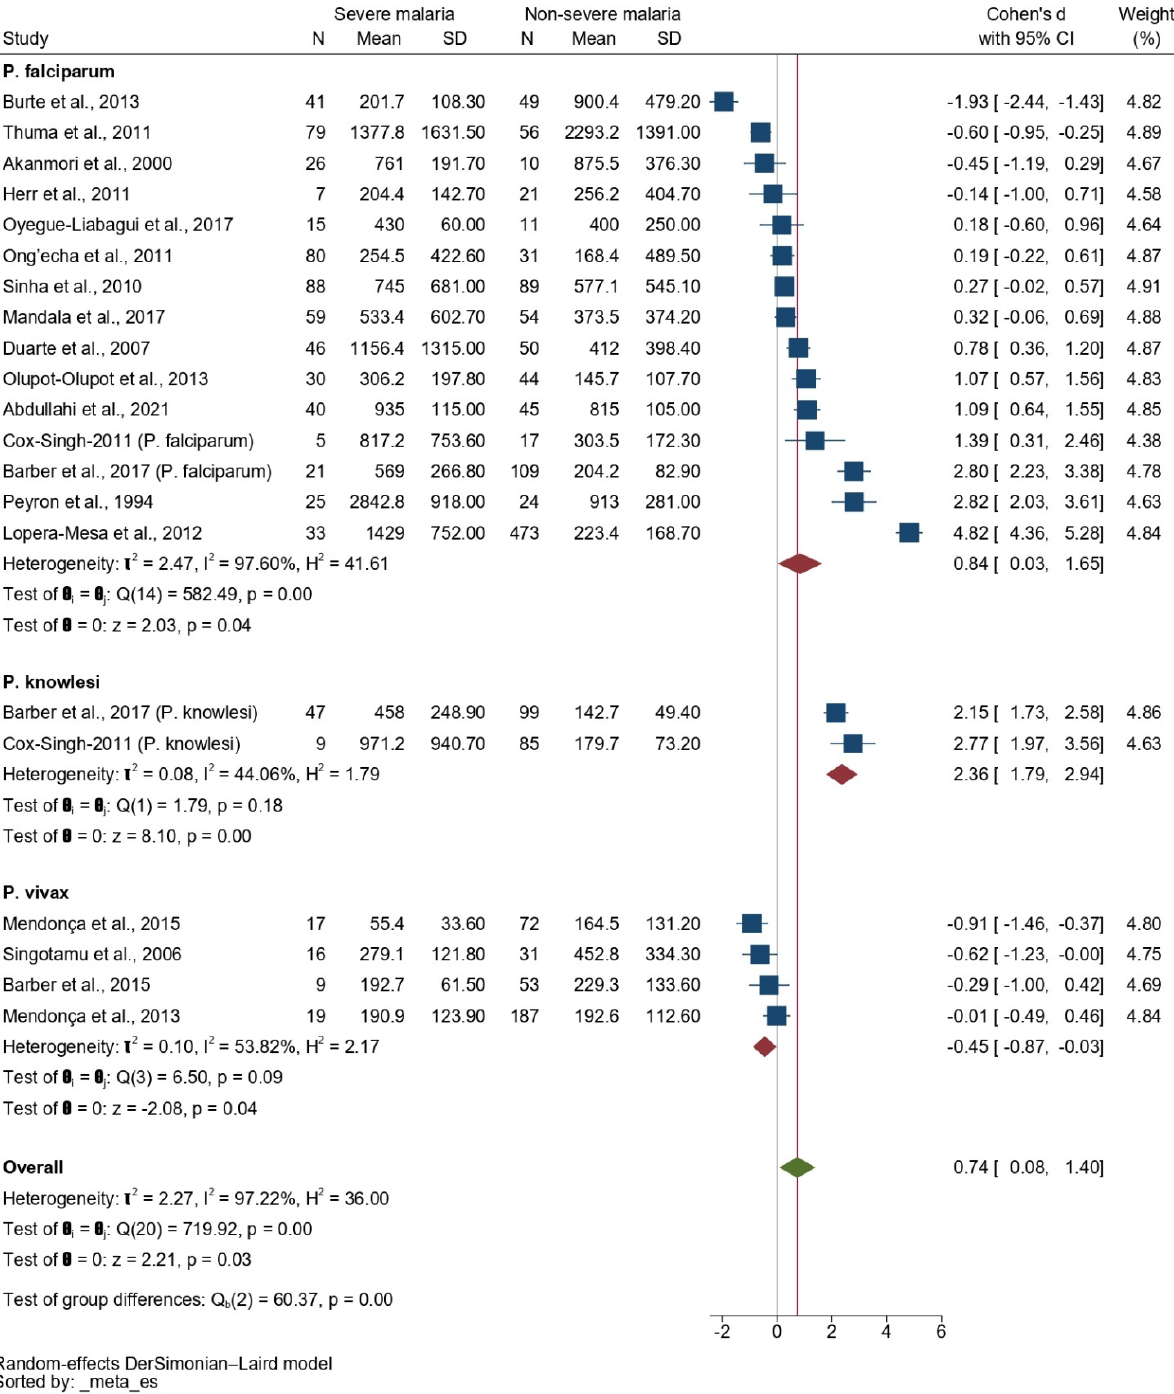
Figure 5. Forrest plot showing the SMDs of IL-10 levels between patients with severe malaria and those with non-severe malaria, stratified by Plasmodium species. Abbreviations: CI, confidence interval; SD, standard deviation. Symbols: blue square, point estimate (SMD of IL-10); green diamond, pooled effect estimate (pooled SMD of IL-10); red diamond, pooled effect estimate in each